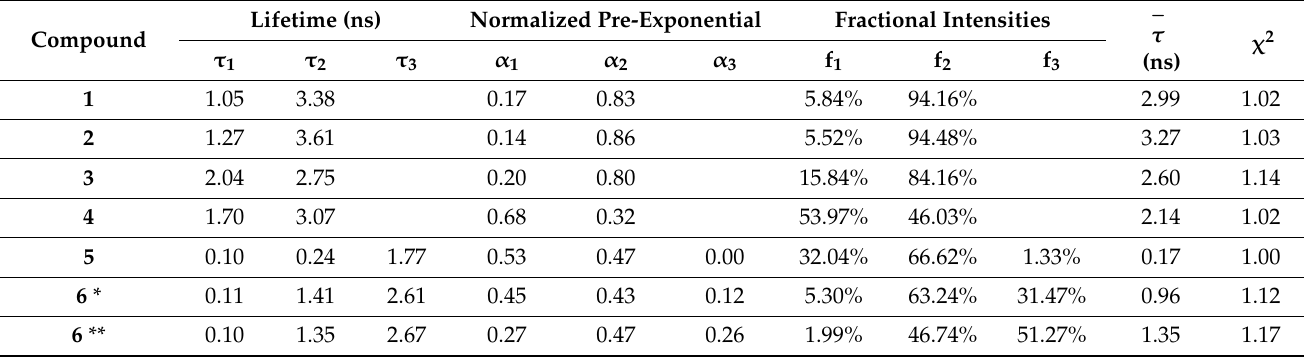
Table 3. Fluorescence lifetime data of ESIPT compounds in CH 2 Cl 2